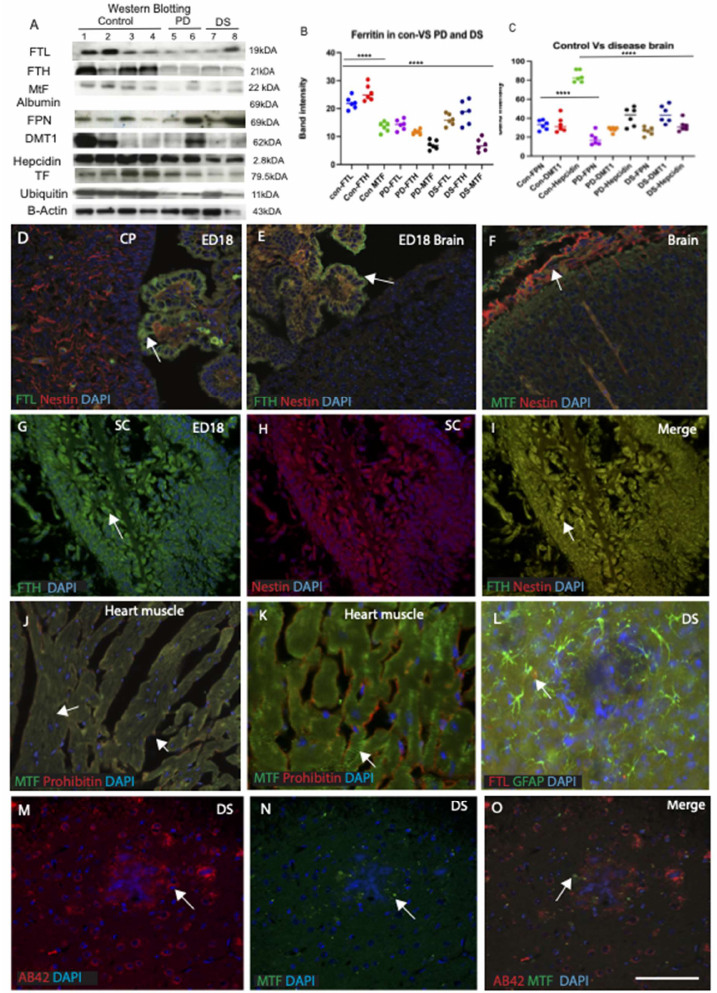
Figure 3. Ferritin light-heavy chain and mitochondrial ferritin protein levels and cellular distribution in different brain compartments. Western blotting (WB) of basal ganglia brain was analysed using PD, DS, and age-matched control samples ( n = 6). A single ~19 kDa band consistent with FTL, FTH (21 kDa), MtF (~22 kDa), hepcidin (~2.8 kDa), TF (79.5 kDa), and ubiquitin (11 kDa) were detected ( A ). The highest levels were seen in the control brains (lane 1–4) compared to PD (lane 5,6) and DS